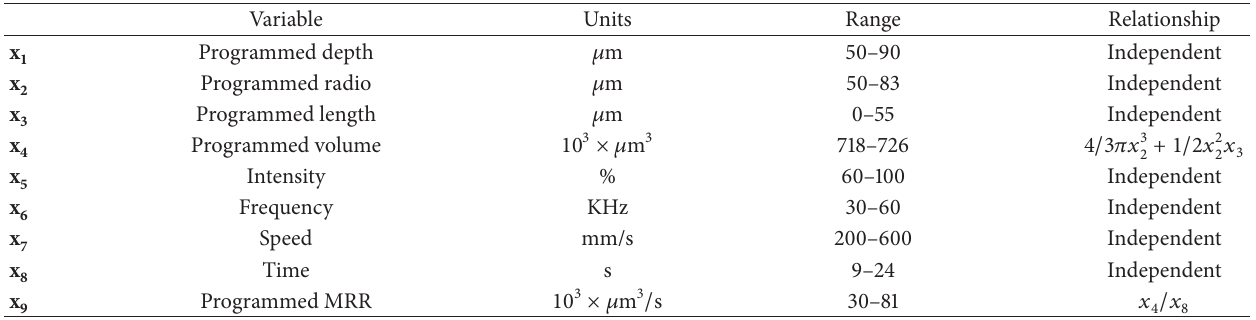
Table 4: Input variables.